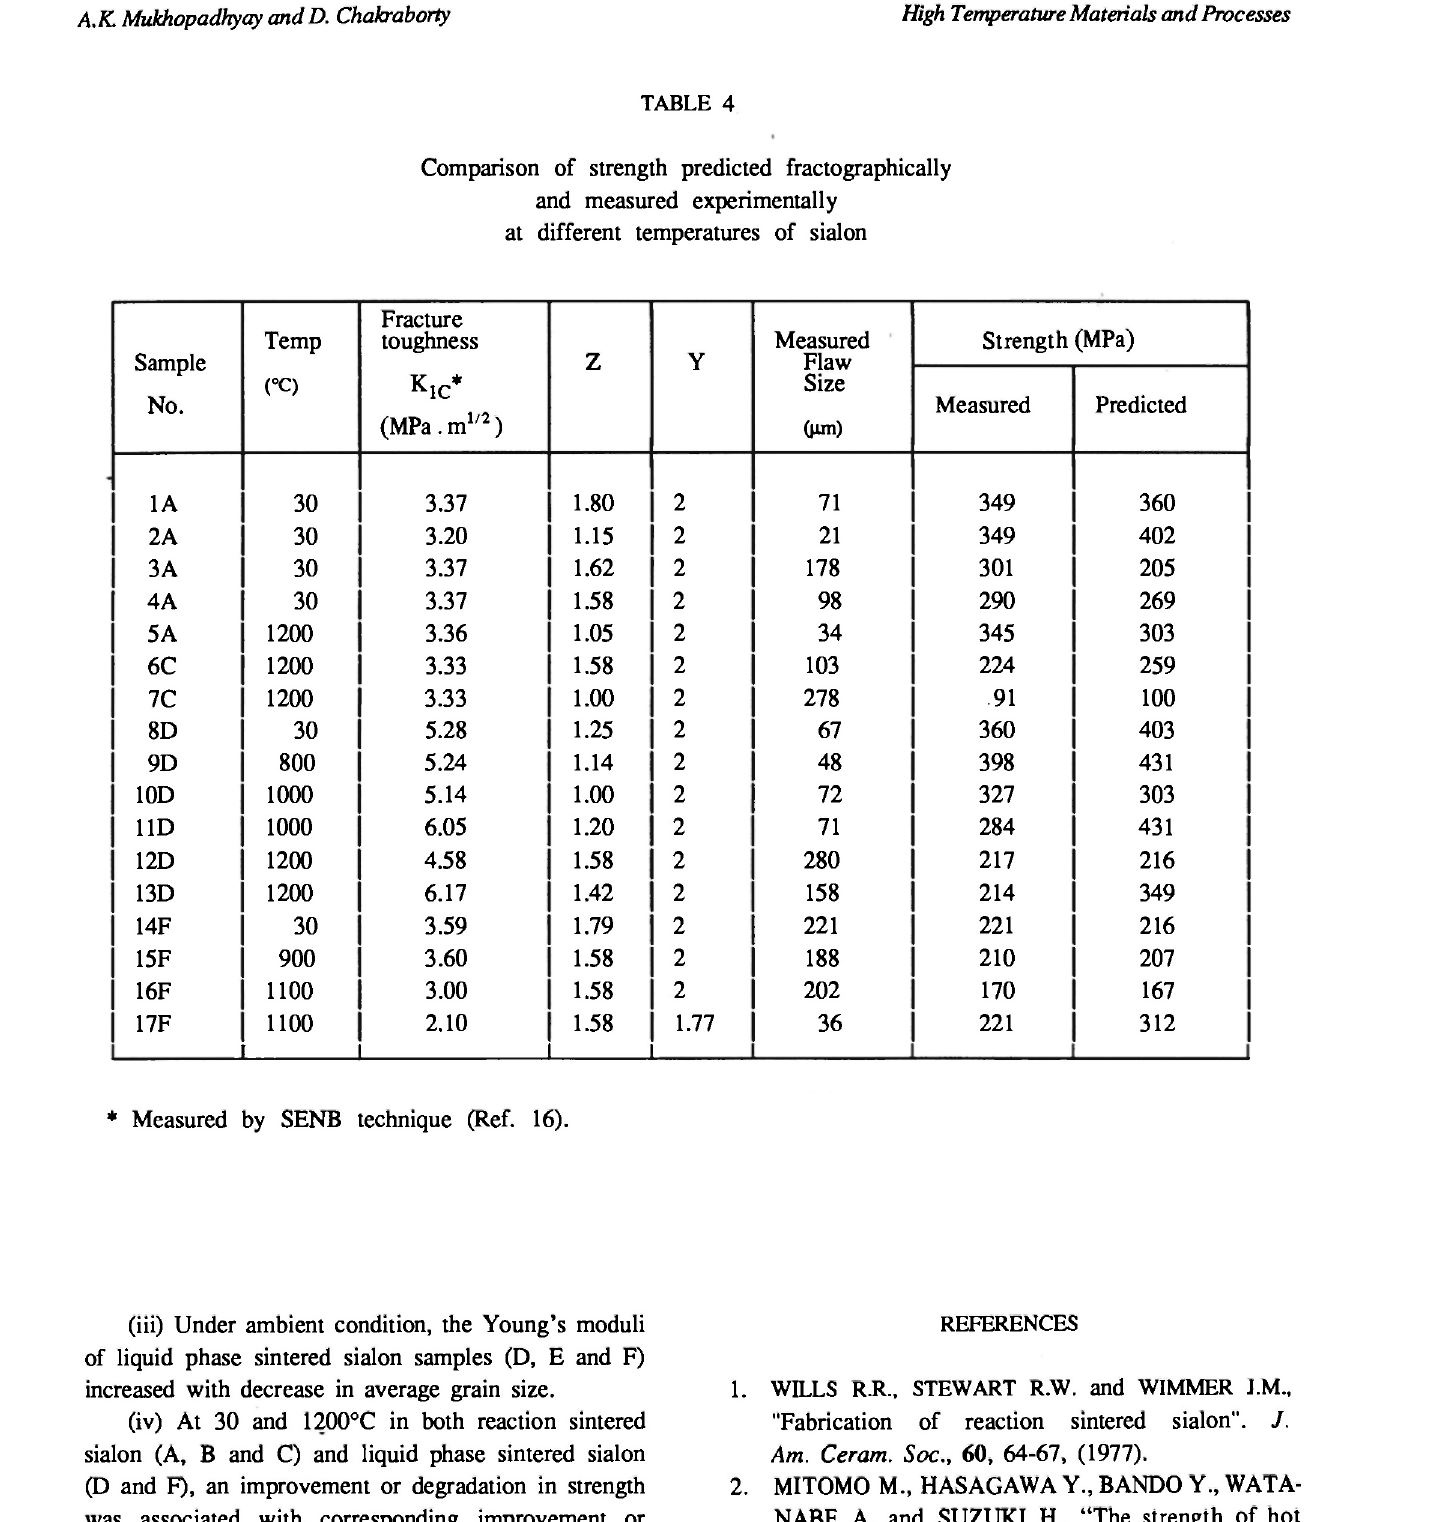
Comparison of strength predicted